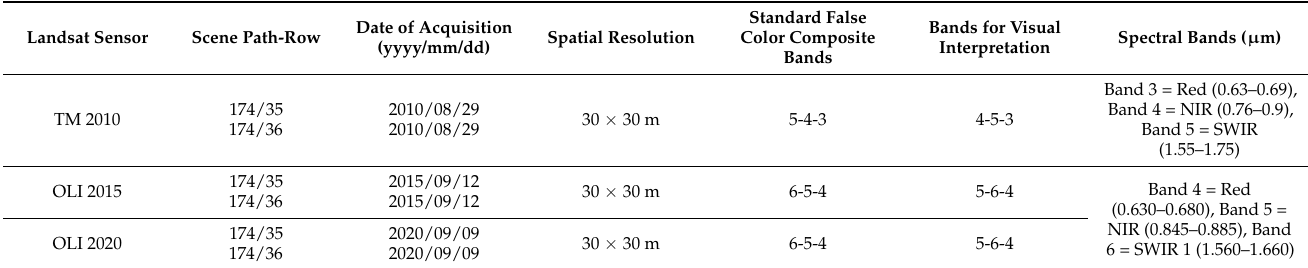
Table 2. Details of the Landsat images and bands used in the classification and analysis [61]. Landsat Sensor Scene